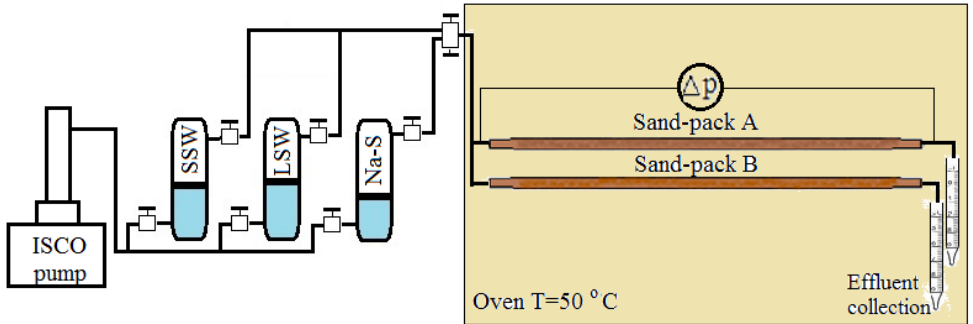
Figure 2. Schematic illustration of the experimental set up for dual-permeability sand-pack flooding. LSW: low salinity